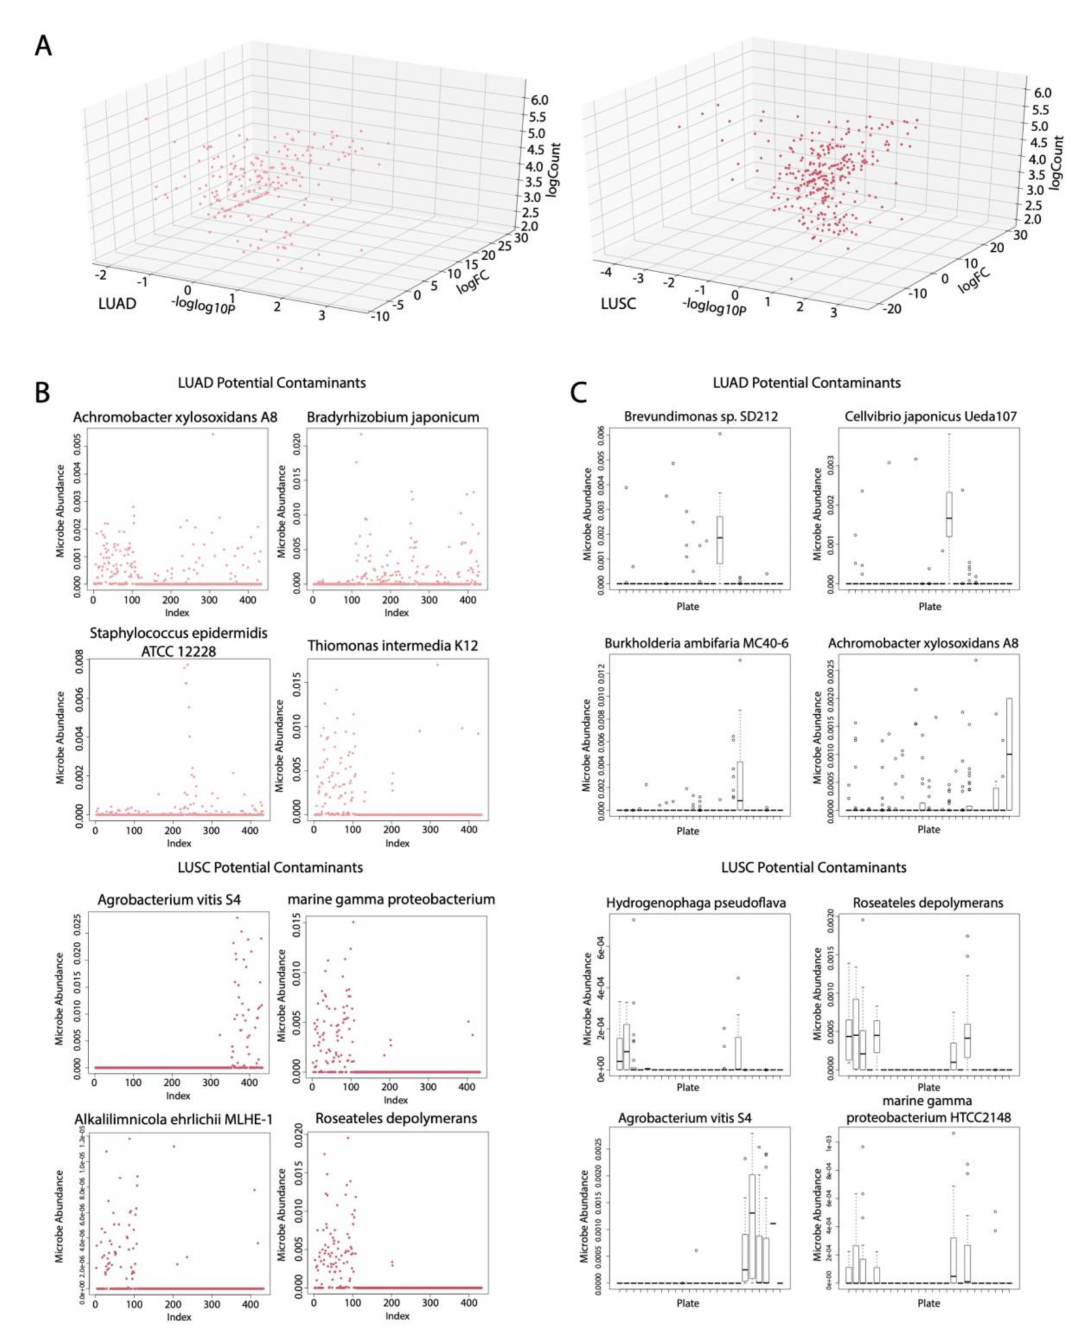
Figure 2. Contamination correction results. ( A ) Di ff erentially abundant microbes from comparing cancer samples vs. normal samples in LUAD and LUSC (Kruskal–Wallis test, p < 0.05). ( B ) Dot plot visualizing potential microbial contaminants according to date sequenced using an algorithm that relies on divisive clustering of abundance for LUAD and LUSC. ( C ) Boxplots depicting potential microbial contaminants according to the plate ID for LUAD and LUSC ( p <